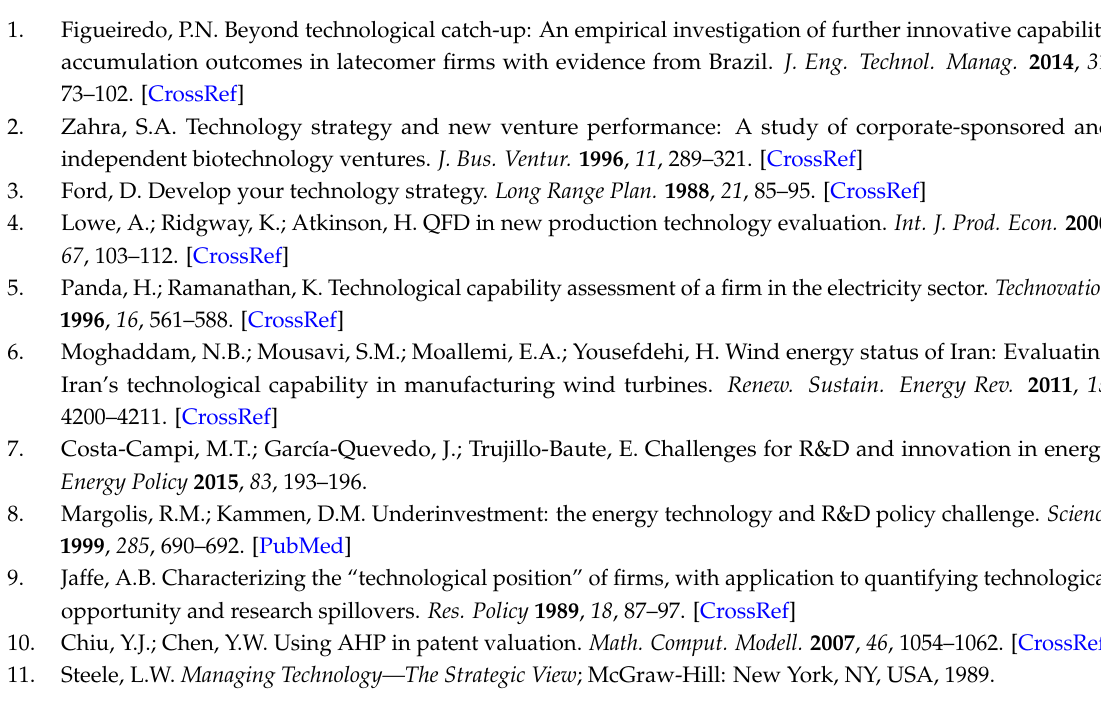
Figueiredo, P.N. Beyond technological catch-up: An empirical investigation of further innovative capability accumulation outcomes in latecomer firms with evidence from Brazil. J. Eng. Technol. Manag. 2014 , 31